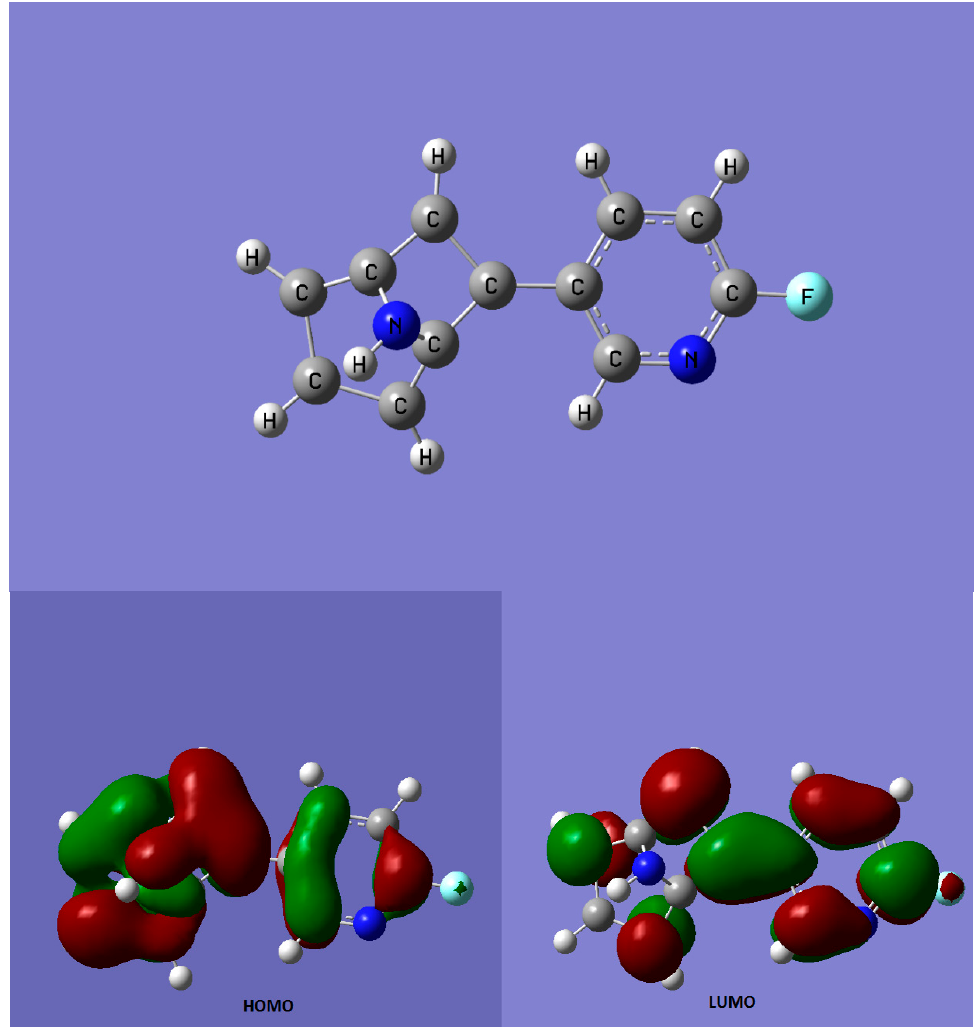
Figure 1. Chemical structure of flubatine (up) and charge distribution for the highest occupied molecular orbital (HOMO) and lowest unoccupied molecular orbital (LUMO) states (down). Methods: The ab initio calculations were performed with Gaussian 16w B.01 and modeled with GaussView 6.0.16 (Andreescu Labor Soft S.R.L., Bucharest, Romania). The optimization of the molecule and HOMO and LUMO states were calculated based on semi-empirical method PM6. It is easy to observe that the fluorine atom, for the HOMO statehas a positive charge; all the electrons are attracted on the rings. On LUMO state, the fluorine atom is partially shielded.